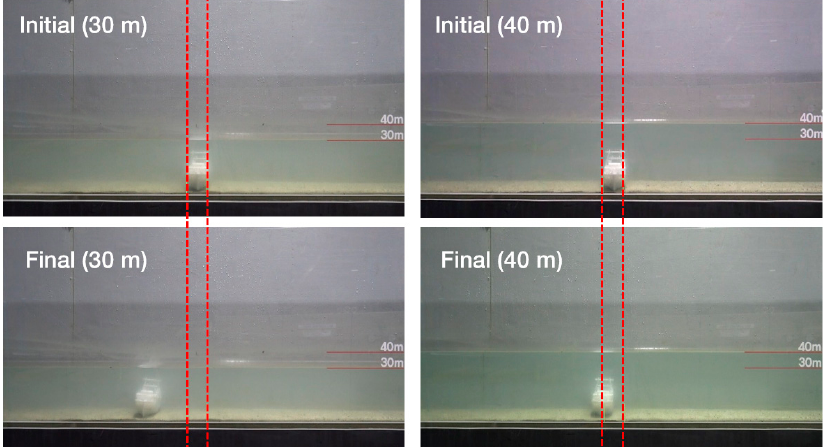
Figure 9. Experiment results at water depth of 30 m (wave height: 5.49 m, period: 10.72 s) and at water depth of 40m (wave height: 5.65m, period: 10.72s).